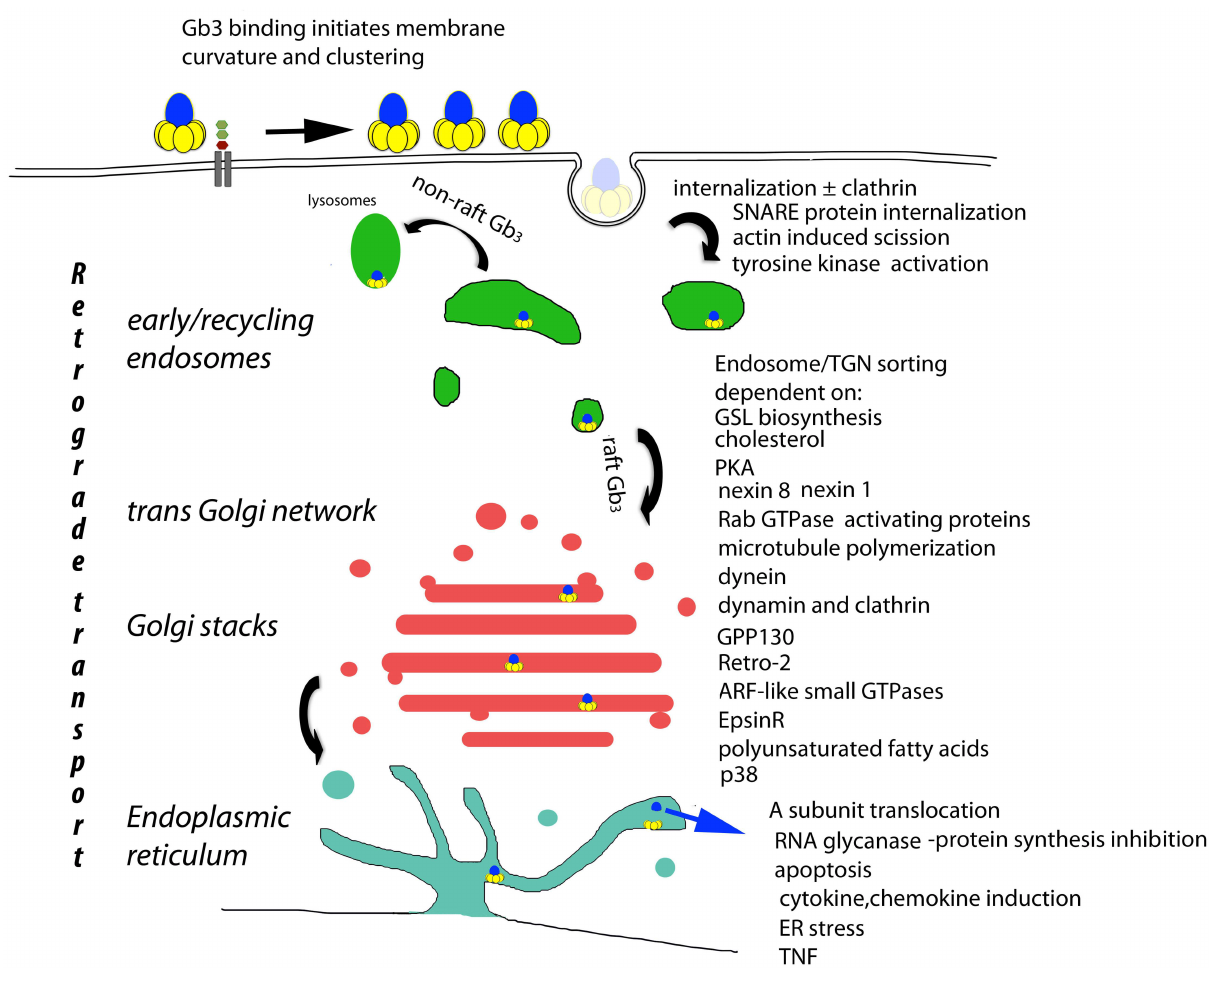
FIGURE 1 | Basis of cellular VT cytopathology. The retrograde transport of plasma membrane bound VT (Römer et al., 2007) is the central determinant of cytopathology. Receptor mediated endocytosis ( Sandvig et al., 1989; Khine et al., 2004; Bujny et al., 2007; Rydell et al., 2014; Renard et al., 2015), tyrosine kinase activation (Katagiri et al., 1999; Mori et al., 2000; Lauvrak et al., 2005; Utskarpen et al., 2010), non-raft Gb 3 bound VT lysosomal transit (Falguieres et al., 2001) raft Gb 3 bound VT endosomal/TGN transit [and A subunit ER/cytosolic transport] ( Lord et al., 2003; Spooner and Lord, 2012) are all essential to end stage cytopathology ( Brigotti et al., 1997; Foster et al., 2000; Fujii et al., 2003; Yamasaki et al., 2004; Jandhyala et al., 2008; Stearns-Kurosawa et al., 2010; Leyva-Illades et al.,